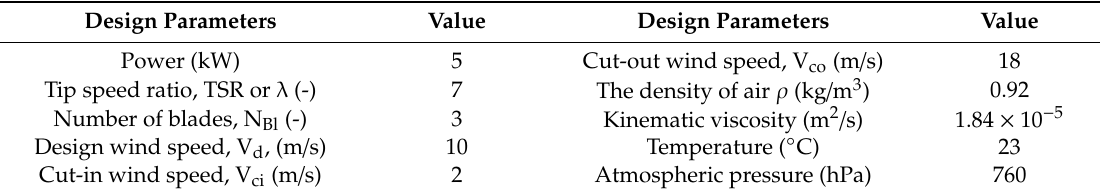
Table 2. Summary of design parameters.